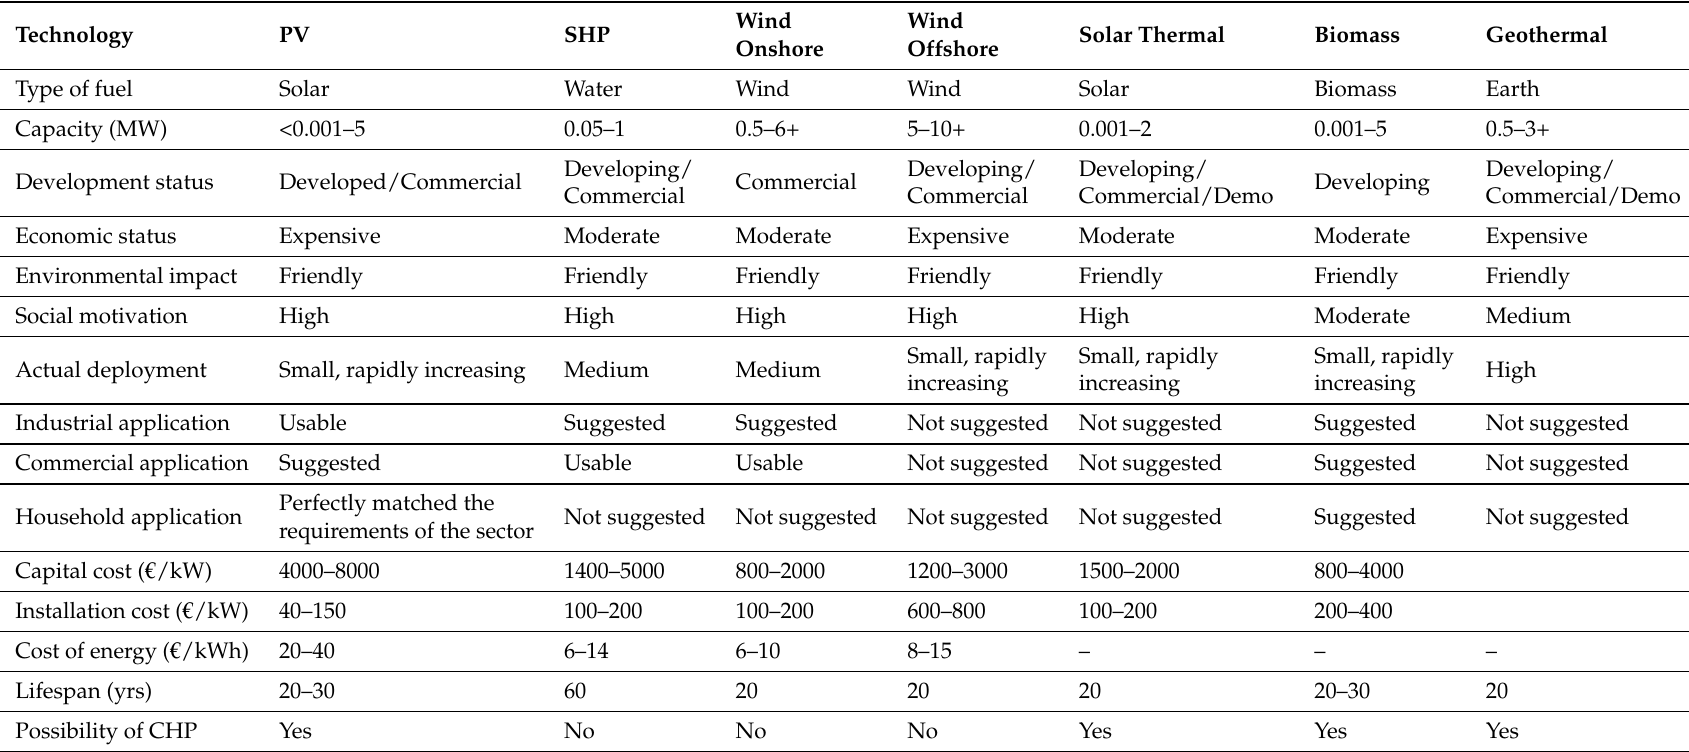
Table 1. Summary of renewable energy-based microgrid technologies [1,46]. PV:photovoltaic; SHP:small hydropower; CHP:combined-heat and